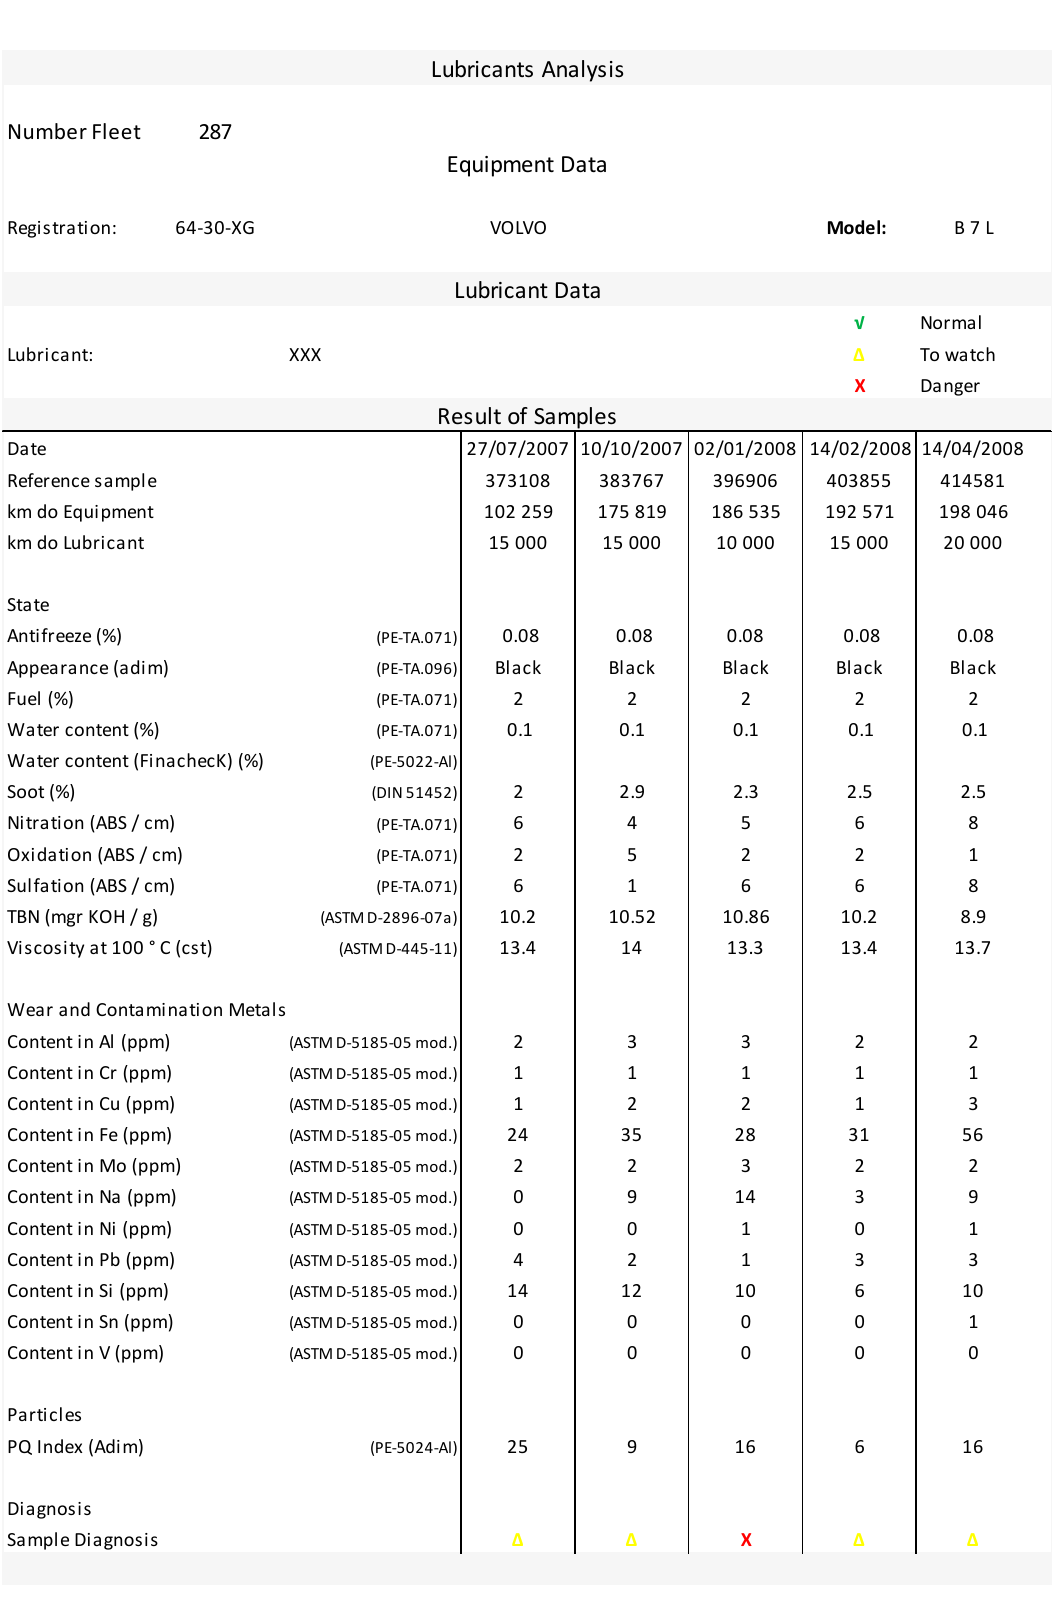
Figure 2. Database in Excel.